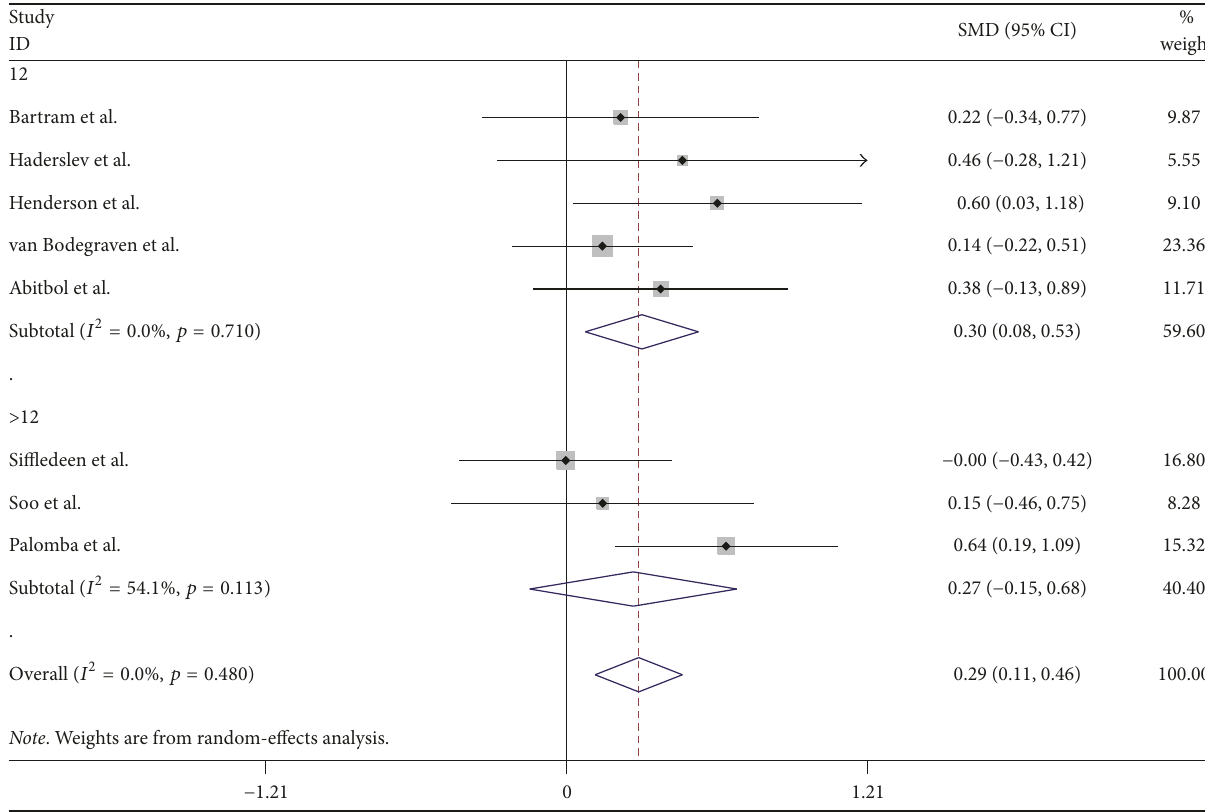
Figure 4: Randomized controlled trials of bisphosphonates in improving total hip BMD in IBD. Forest plot showing the weighted mean differences and 95% confidence interval of the percentage change in bone mineral density at the total hip in the bisphosphonate and control groups. A subgroup analysis of the treatment duration of the two groups is also